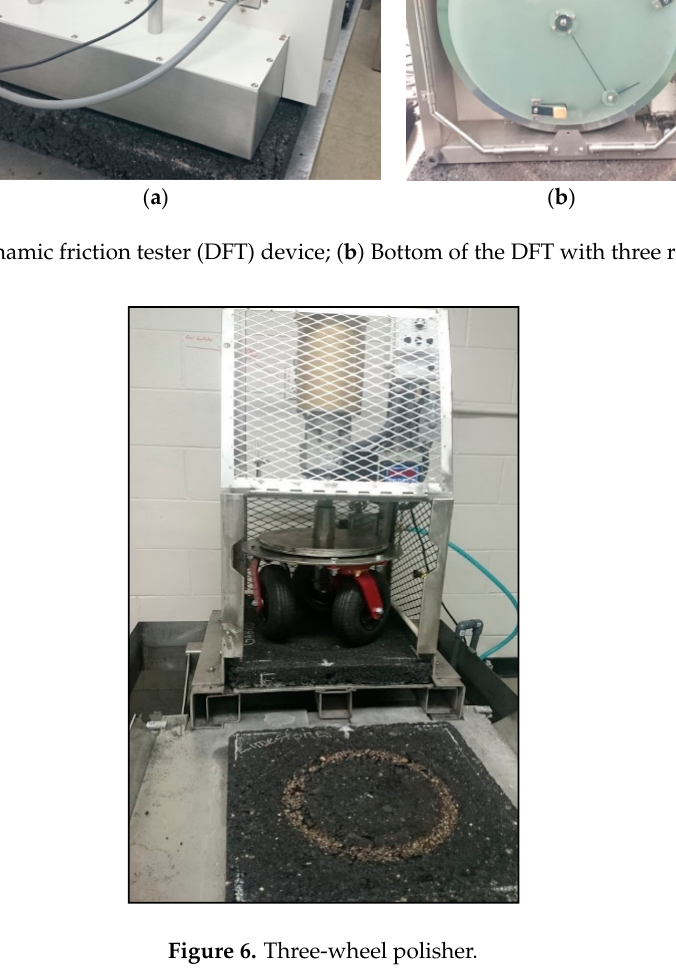
Figure 6. Three-wheel polisher.